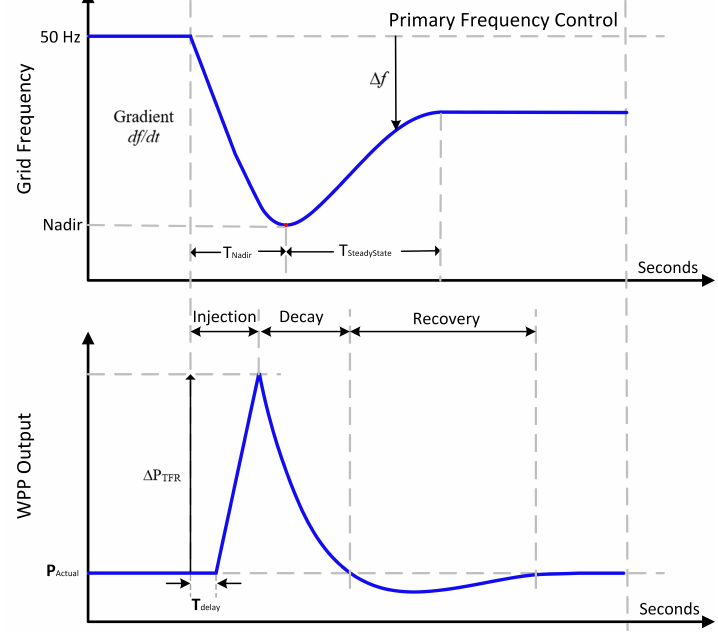
Figure 4. Reference frequency and output power shapes of WPP